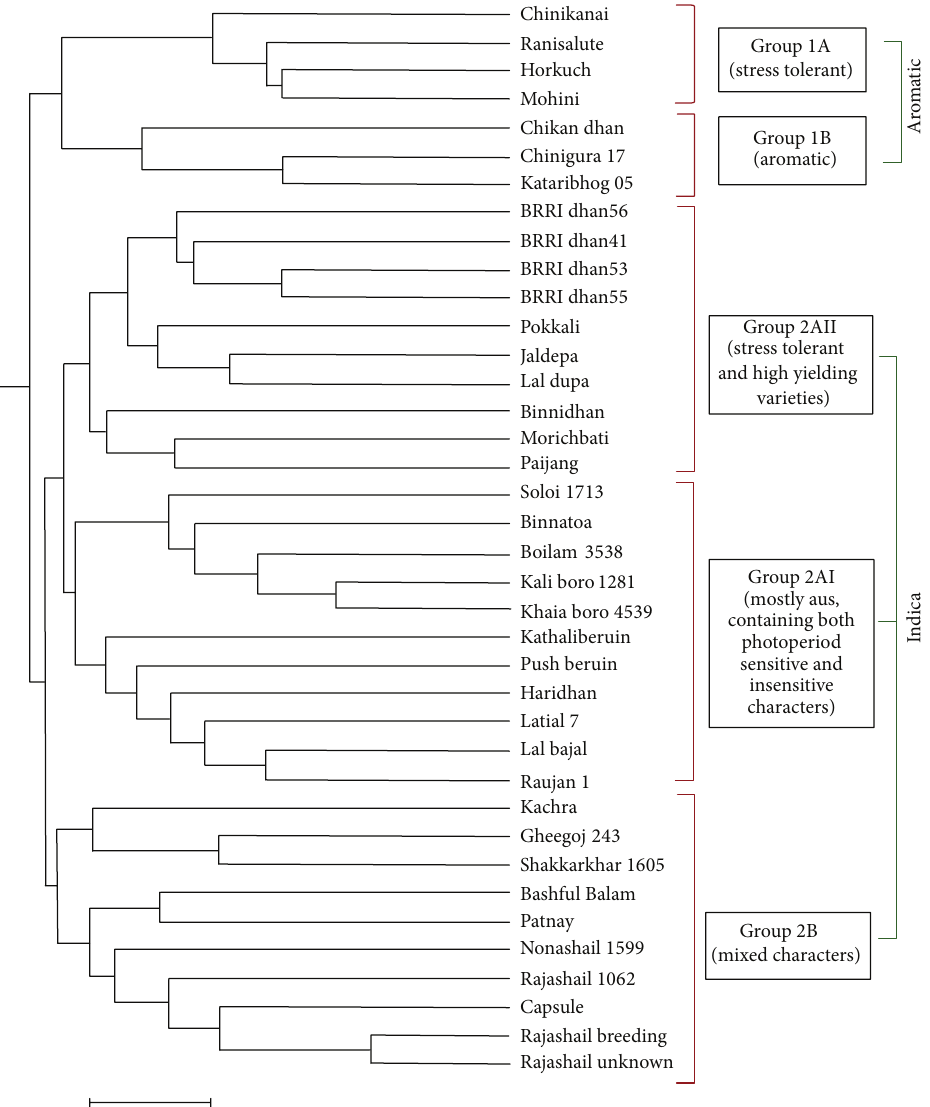
Figure 4: Dendogram constructed based on the polymorphism of the 38 varieties using the 34 markers used in the